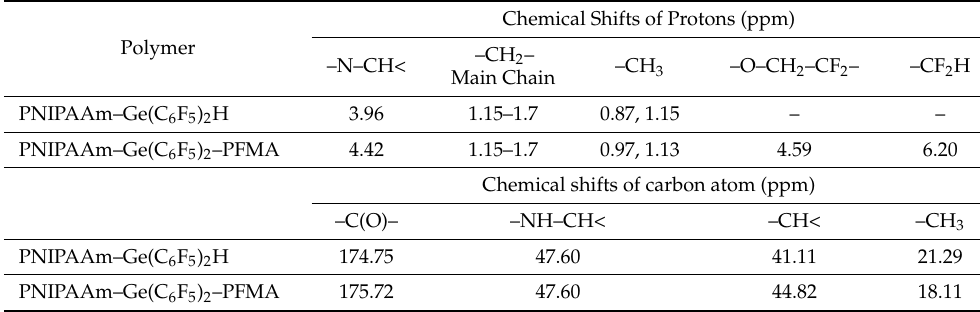
Figure 2. 1 H NMR spectrum of block copolymer PNIPAAm–Ge(C 6 F 5 ) 2 –PFMA in CD 3 OD. Table 2. Assignment of 1 H and 13 C NMR signals of functional polymer PNIPAAm–Ge(C 6 F 5 ) 2 H and Table 2. Assignment of 1 H and 13 C NMR signals of functional polymer PNIPAAm ‒ Ge(C 6 F 5 ) 2 H and block copolymer PNIPAAm–Ge(C 6 F 5 ) 2